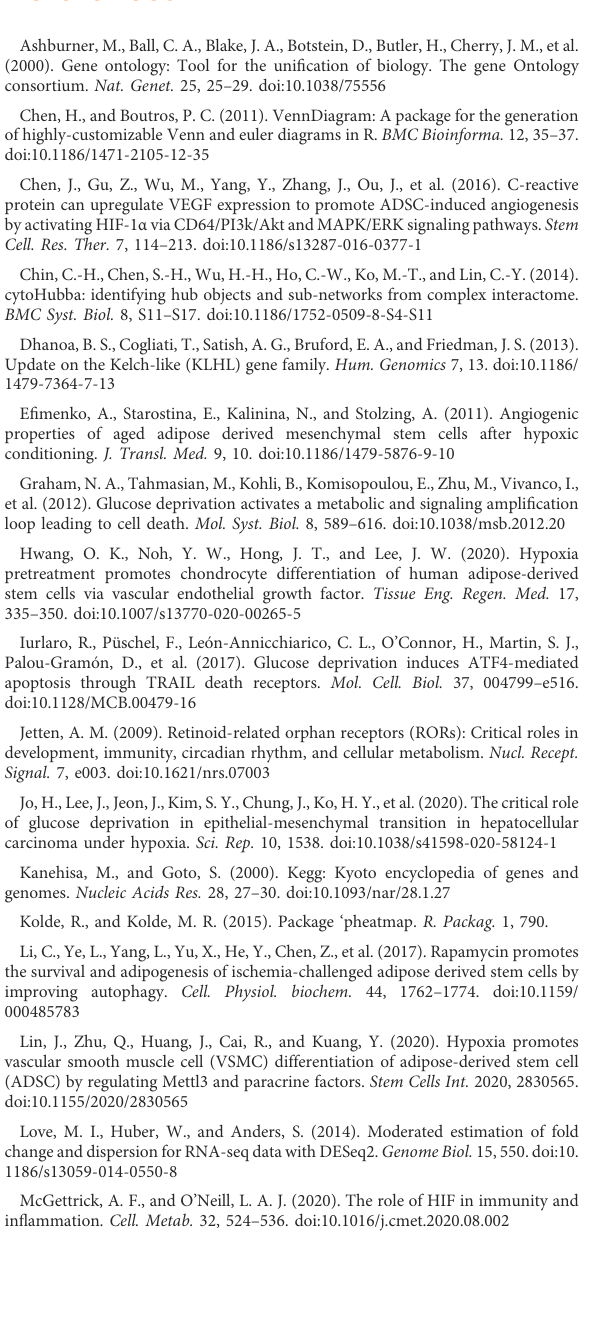
SUPPLEMENTARY FIGURE S3 Gene expression changes in the FOXO signalling pathway. Representation of the differentially expressed genes that were enriched in the FOXO signalling pathway (KEGG: hsa04068). Red boxes indicate the differentially expressed genes. SUPPLEMENTARY FIGURE S4 Gene expression changes in transcriptional regulation. Representation of the differentially expressed genes that were enriched in the transcriptional regulation (KEGG: hsa05202). Red boxes indicate the differentially expressed